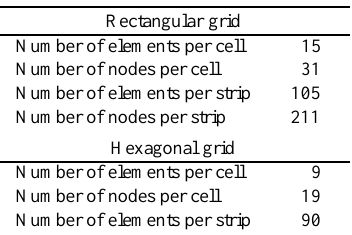
Table 6 FE configuration of cylindrical